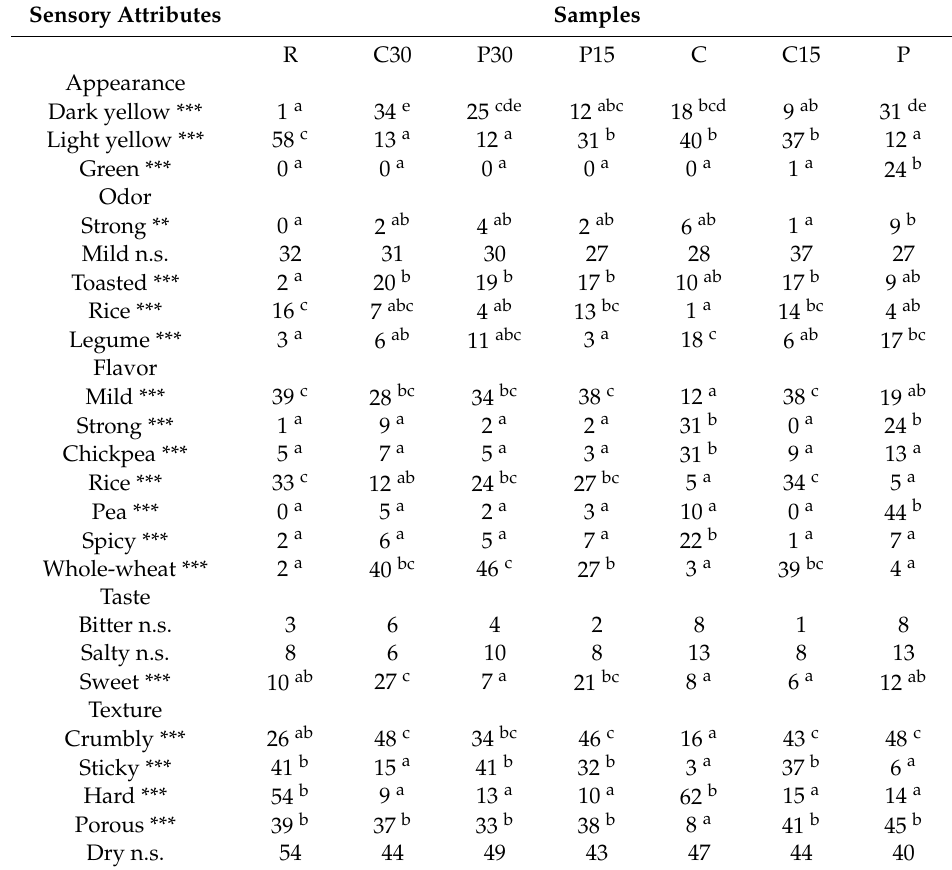
Table 3. Frequency counts (%) of check-all-that-apply (CATA) terms used to describe the extruded snacks and results of Cochran’s Q test for comparison among the